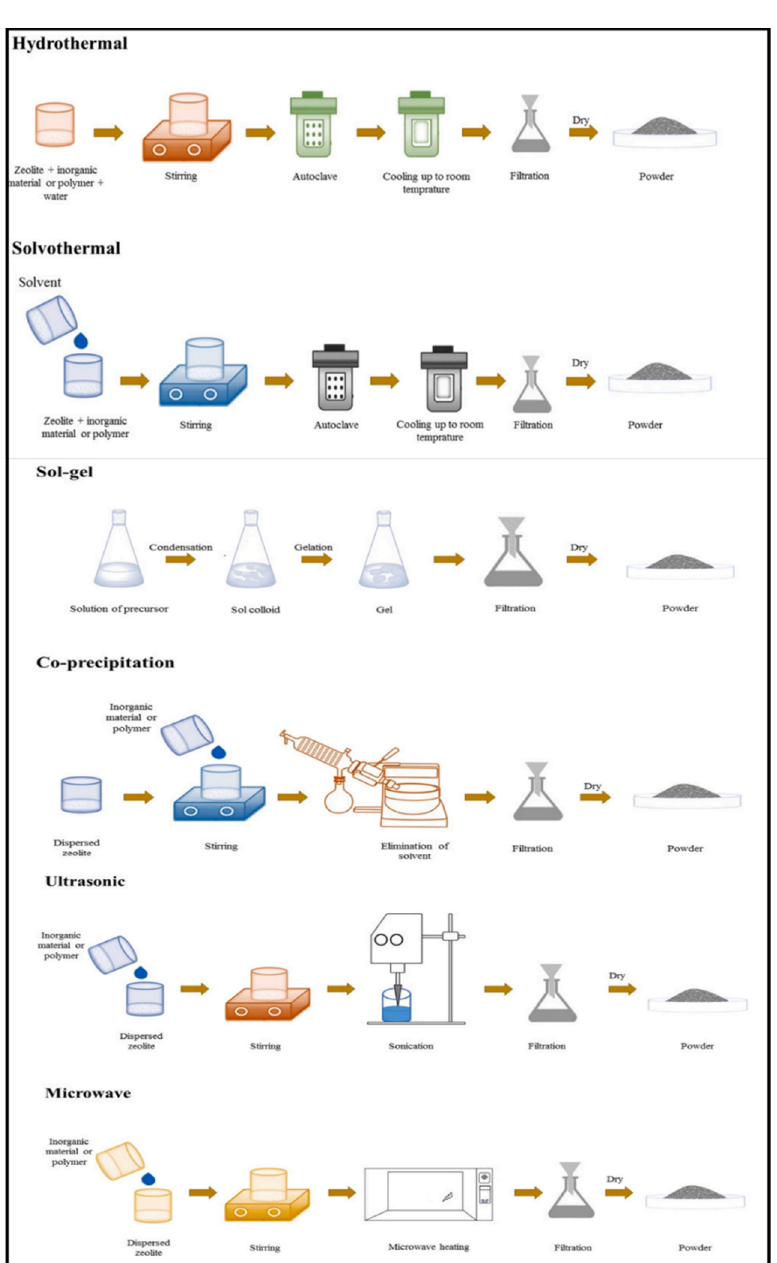
Figure 12. Synthesis processes of zeolite/metal oxide composites. Reprinted with permission from Ref. [34]. Copyright 2021 Elsevier.